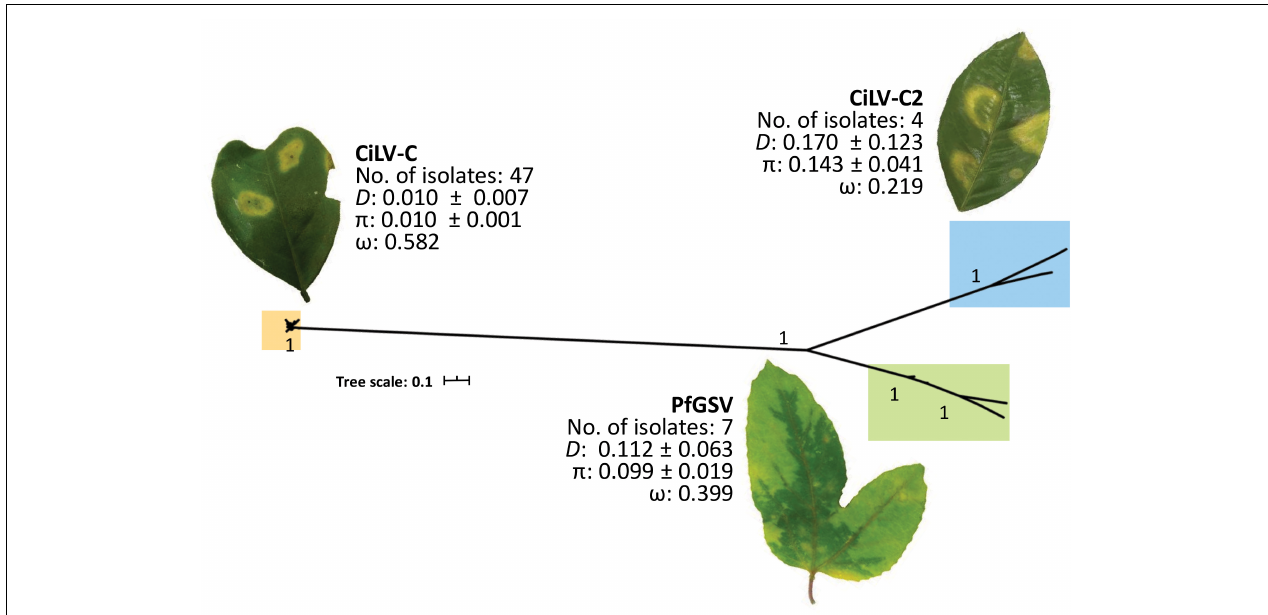
FIGURE 2 | Phylogenetic analysis of P15 proteins and intra-species variability of ORF p15 from cileviruses. Nucleotide sequence alignments were performed using the MAFFT algorithm (Katoh and Standley, 2013). The best-fit nucleotide substitution model was estimated using MEGA X v. 10. 1. 8 (Kumar et al., 2018). Model HKY + G (Hasegawa et al., 1985), with the lowest Bayesian information criterion (BIC), was used for the estimation of the phylogenetic relationships. The phylogenetic tree was inferred using the Maximum Likelihood method implemented in the Galaxy platform (Afgan et al., 2018). The reliability of the inferred evolutionary relationships was assessed by 1,000 bootstrapped replications. The tree was edited and visualized using Interactive Tree Of Life (iTOL) v4 (Letunic and Bork, 2019). ORF p15 sequences from 47, 4, and 7 isolates of CiLV-C, CiLV-C2, and PfGSV, respectively, were retrieved from the GenBank database accessed on 17th March 2020 ( Supplementary Table 1 ). Intraspecific genetic distance ( D ) and Non-synonymous (dN) and synonymous (dS) rates of substitutions ( ω ) were calculated in MEGA X, and nucleotide diversity ( π ) and the confidence intervals for π values were estimated using DnaSP software v6.12.03 (Rozas et al., 2017). Photo of the CiLV-C2-infected orange leaf is courtesy of Dr. Guillermo Adolfo Leon Martinez, AGROSAVIA, 2021.